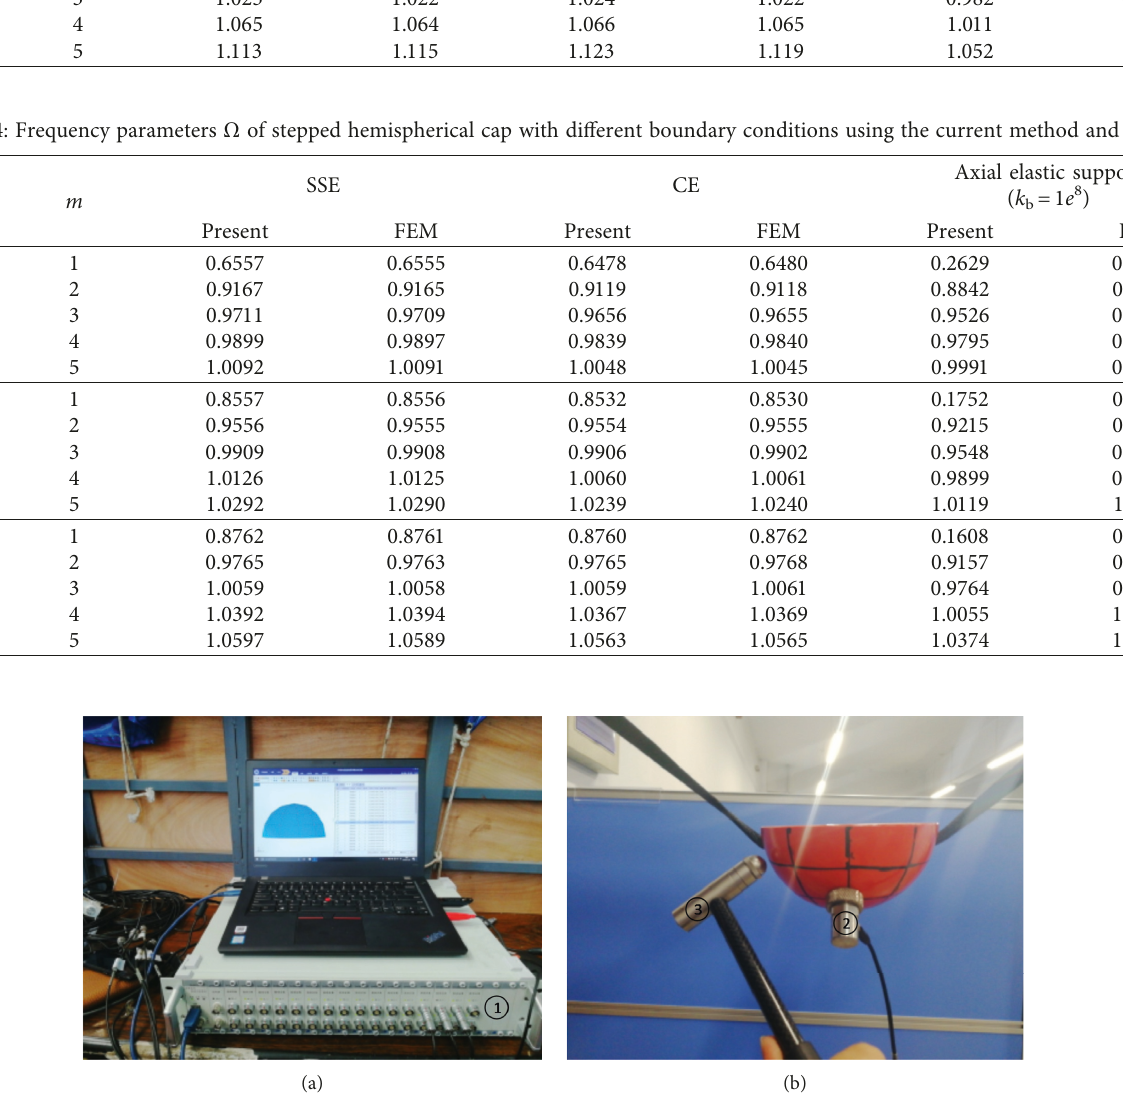
Figure 6: Modal measurement system and test objects. (a) Acceleration data acquisition system. (b) Impact hammer, accelerometer, and the spherical